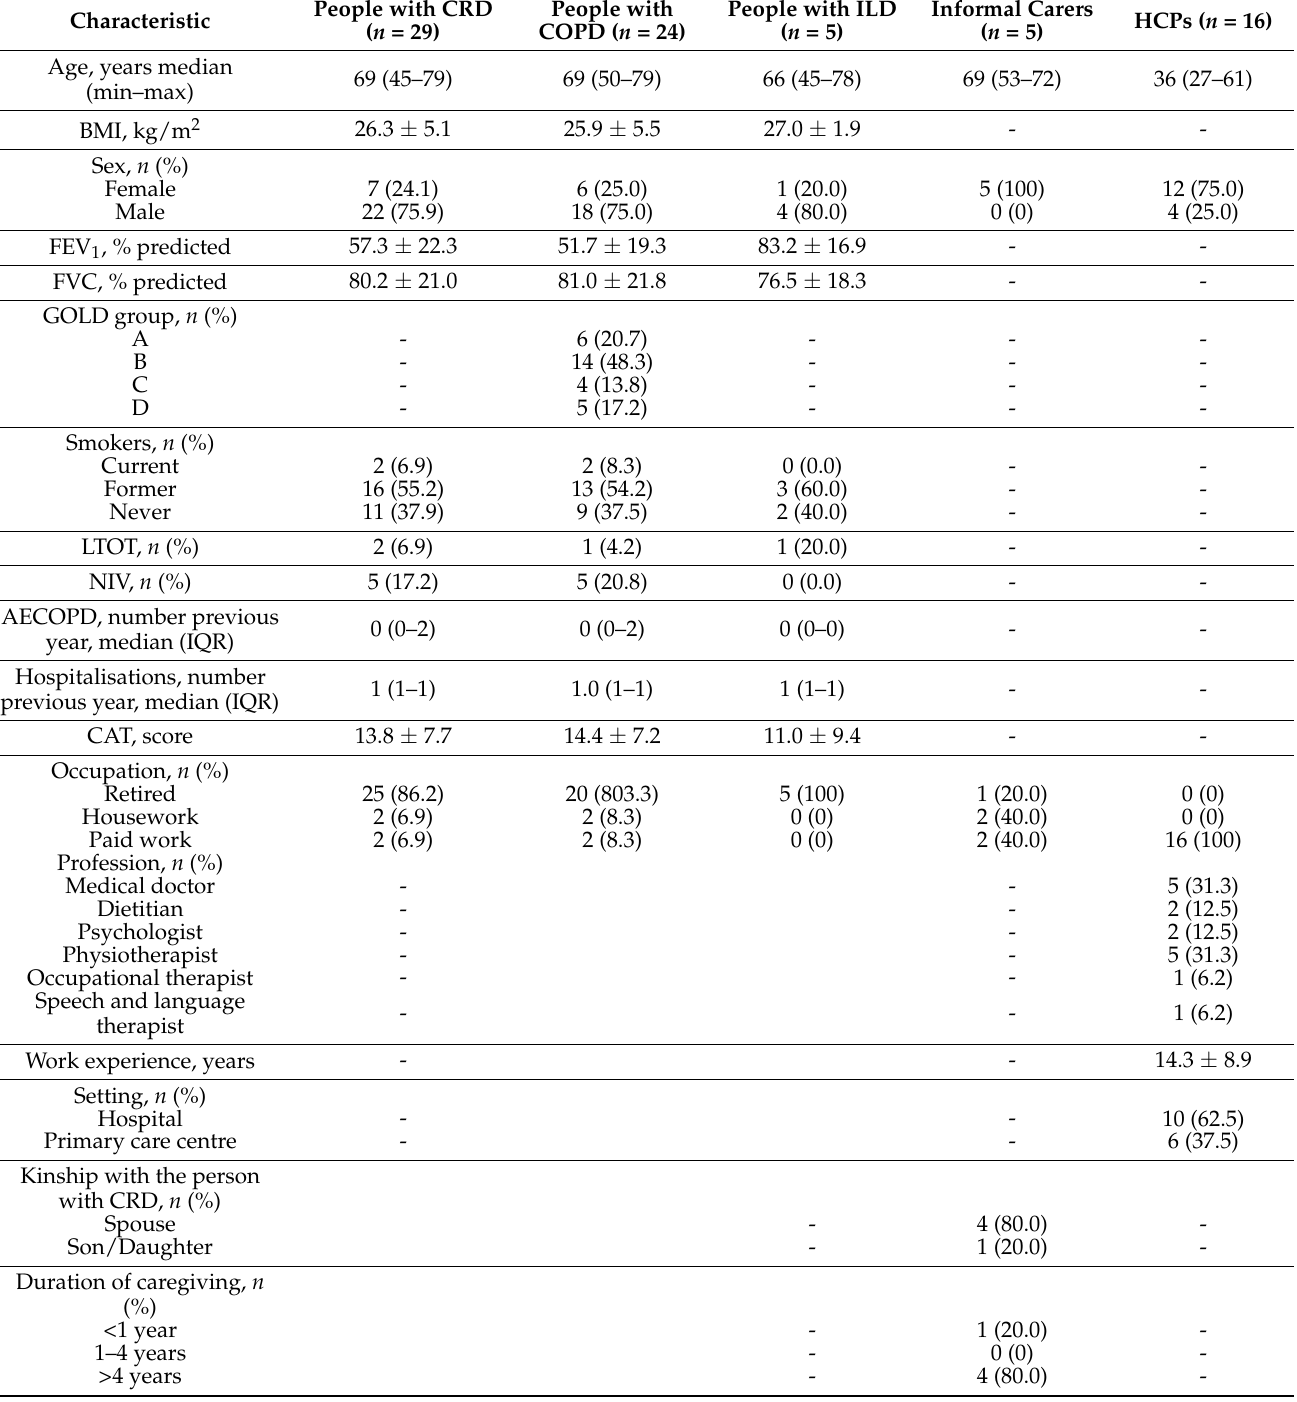
Table 2. Characteristics of the participants included ( n =